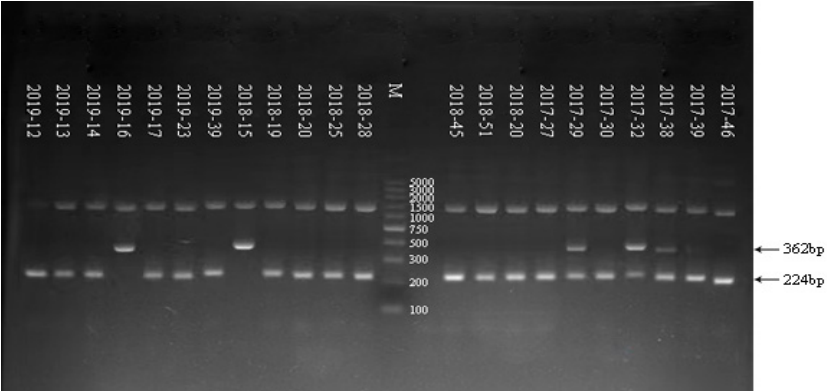
Figure 2. Electrophoretic results of Rotavirus P genotyping in some samples from 2017 to 2019. Table 5. Electrophoresis results of G/P typing of rotavirus from 2017 to 2019.